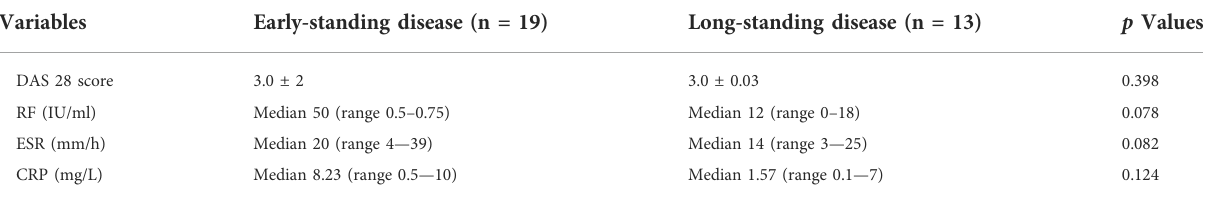
TABLE 3 Clinical characteristics of RA patients 6 months after therapy.